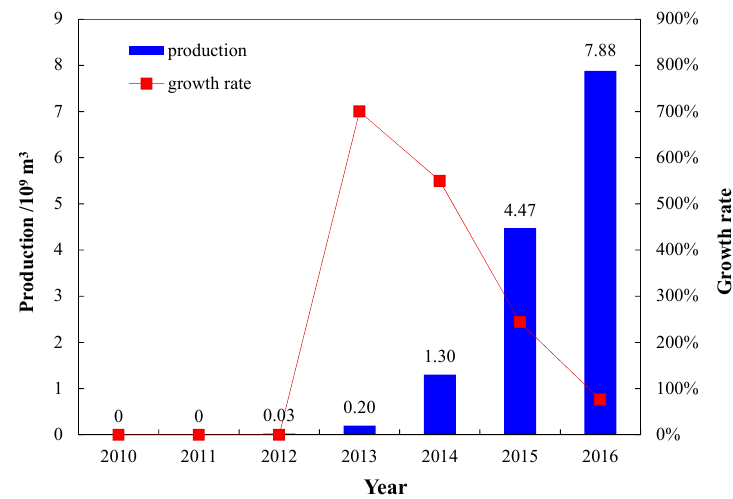
Figure 5. China’s shale gas production increased rapidly from 2010 to 2016.